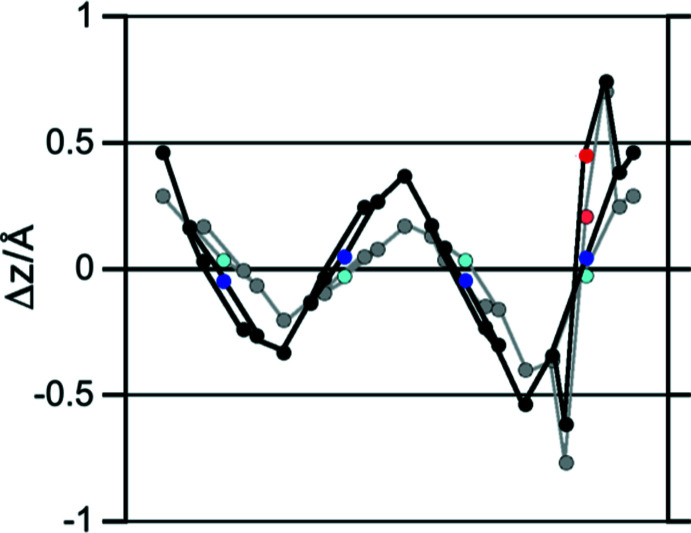
Out-of-plane displacement plots of macrocycles of the title compound 1d (black trace) and morpholino­chlorin 1b (gray trace).